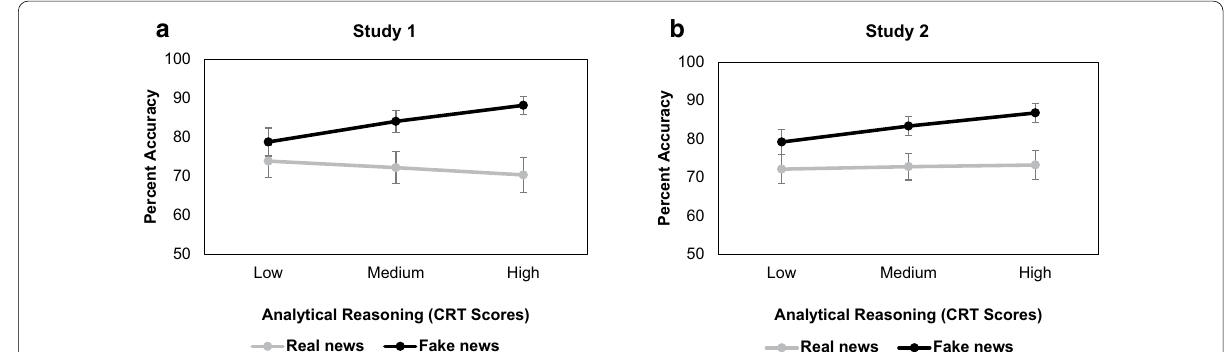
Fig. 1 Percent accuracy for real (gray line) and fake (black line) news articles across levels of analytical reasoning (continuous; indexed by Cognitive Reflection Test (CRT) scores) in Study 1 (Panel A) and Study 2 (Panel B). Error bars denote standard errors. The medium analytical reasoning level indicates the mean CRT score in the current sample while the low and high levels indicate 1 SD below and above the mean CRT score, respectively. The y-axis start point reflects the 50% chance level. Consistent across both studies, real news accuracy did not change across levels of analytical reasoning, while accuracy for fake news increased with higher analytical